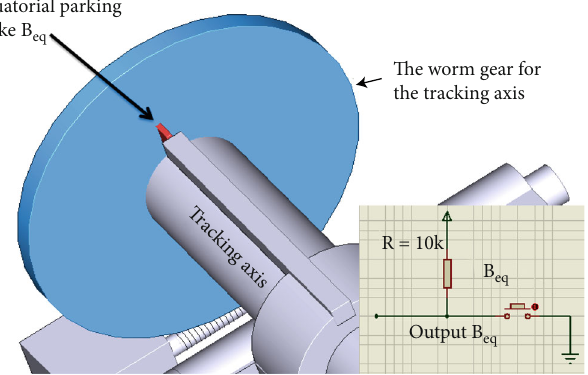
Figure 37: Equatorial parking brake B